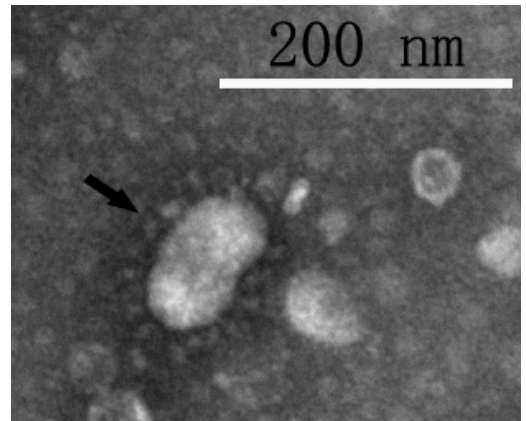
Figure 2. Electron microscopy of PDCoV strain CHN-SC2015. The virus particles were resuspended in PBS and negatively stained with 2% sodium phosphotungstic and examined with a transmission electron microscope. The arrow indicates the crown-shaped projections on the virus surface. Bar: 200 nm.